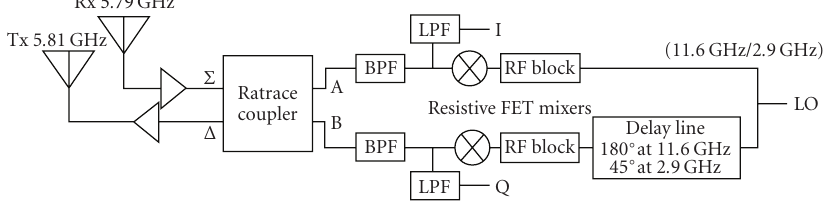
Figure 7: The schematic of the reconfigurable array element.